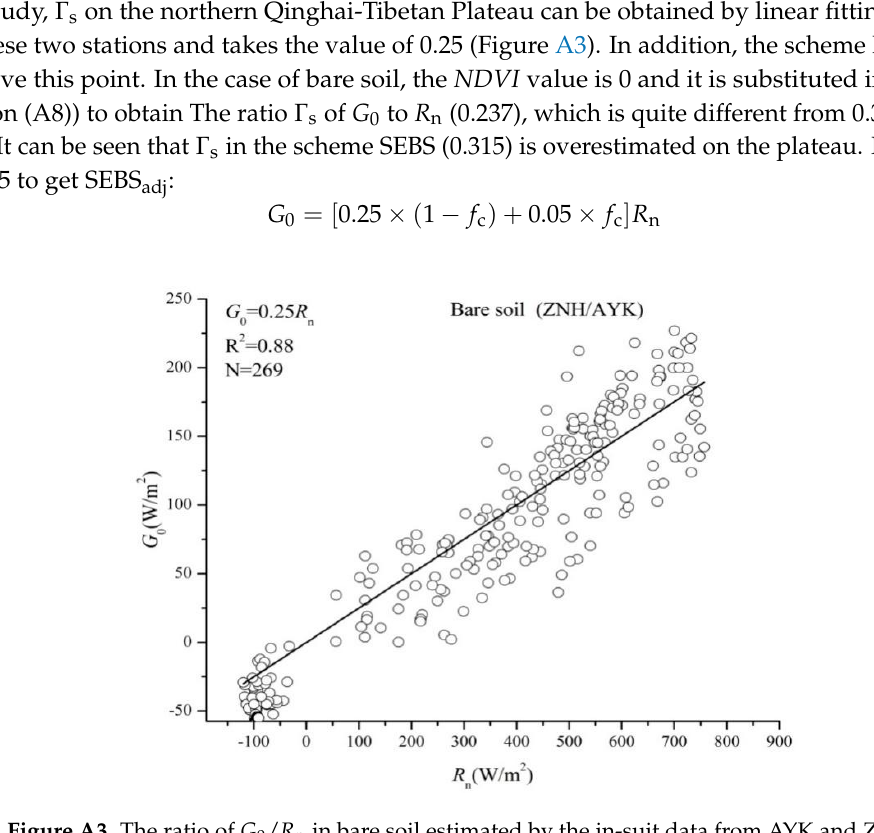
Table B1. Experimental data measured at XDT, TGL, AYK, and ZNH in 2014.